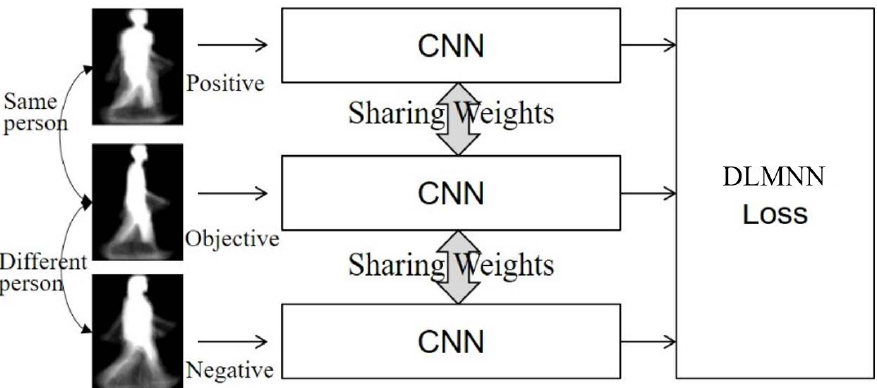
Figure 3: The training framework of the proposed DLMNN method for gait recognition. Triplet GEIs, corresponding to objective, positive and negative instances, are fed into three CNNs with the shared parameter set. The DLMNN loss function is used to train the network models, which makes the positive distance between objective and positive samples as small as possible, meanwhile the negative distance between objective and negative samples larger than the positive distance with a large